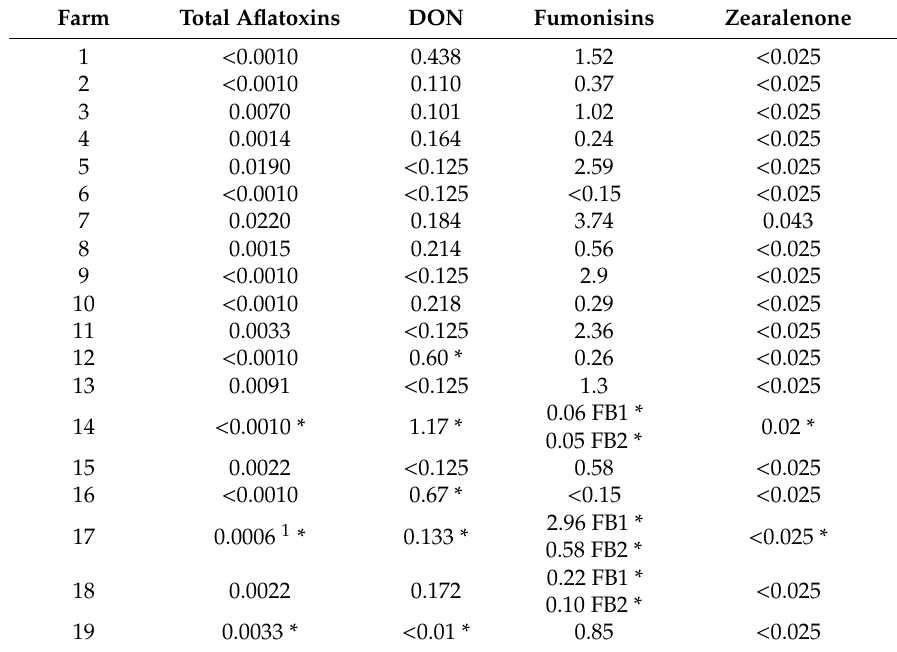
Table 1. Mycotoxin content in the feed mixtures which were sampled for sows (mg / Kg at 88% DM, using ELISA or validated using LC-MS when marked by *). Farm Total Aflatoxins DON Fumonisins